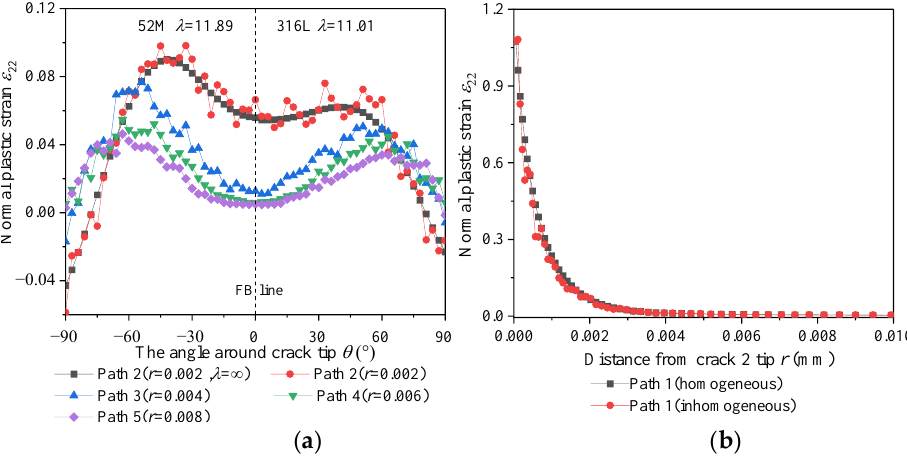
Figure 16. Normal plastic strain under homogeneous and inhomogeneous conditions: ( a ) around the crack 2 tip; ( b ) in front of the crack 2 tip. crack 2 tip; ( b ) in front of the crack 2